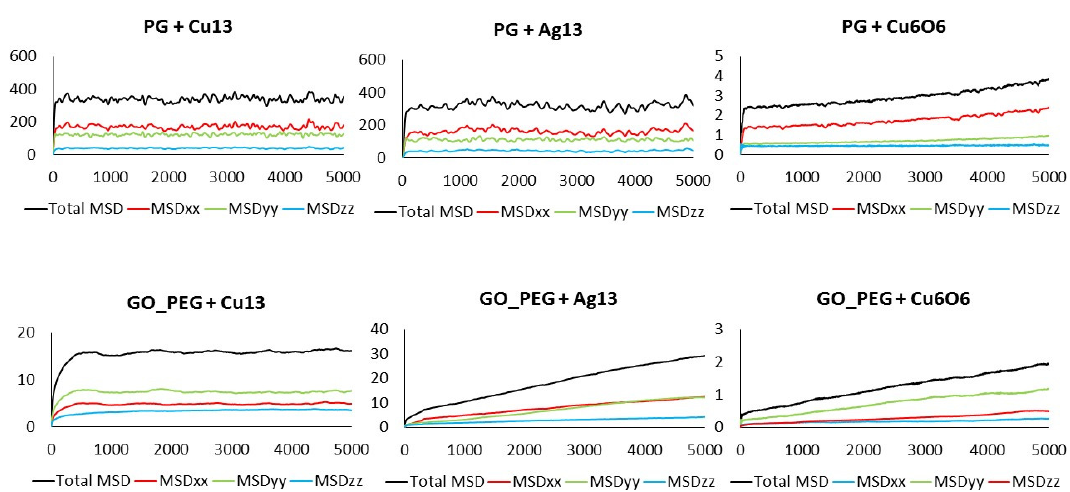
Figure 10. Total MSD (black) and MSD in x, y, and z directions of the clusters interacting with pristine and functionalized graphene monolayers. Axis units: time in ps (x), MSD in Å 2 (y).